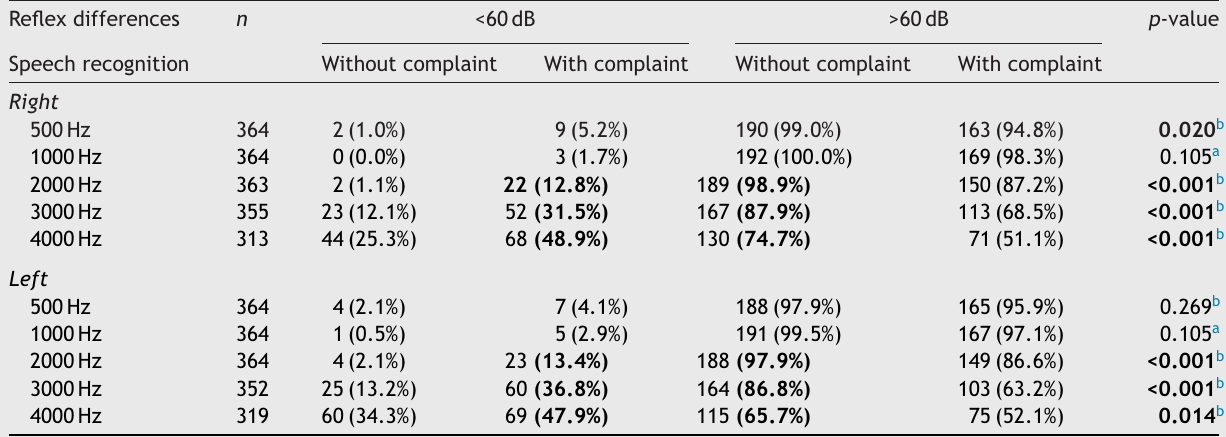
Comparison between speech recognition and occurrence of Metz recruitment.